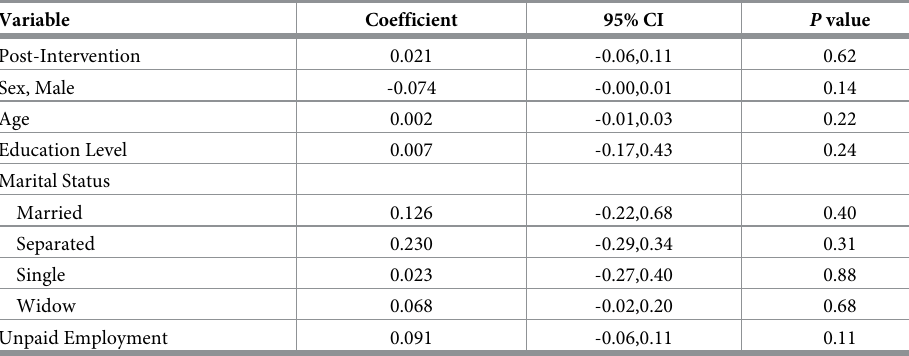
Table 3. Predictors of medication possession among all participants (n =